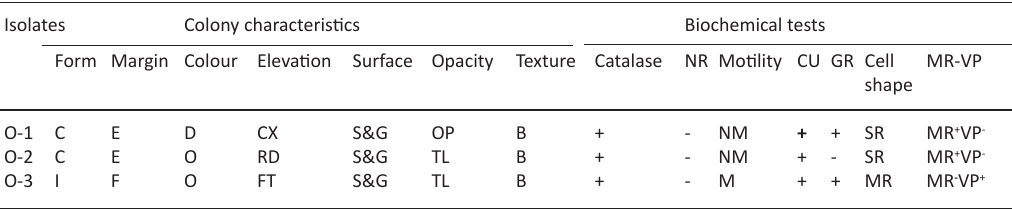
Table 1. Colony morphology and biochemical characters of isolated bacteria Isolates